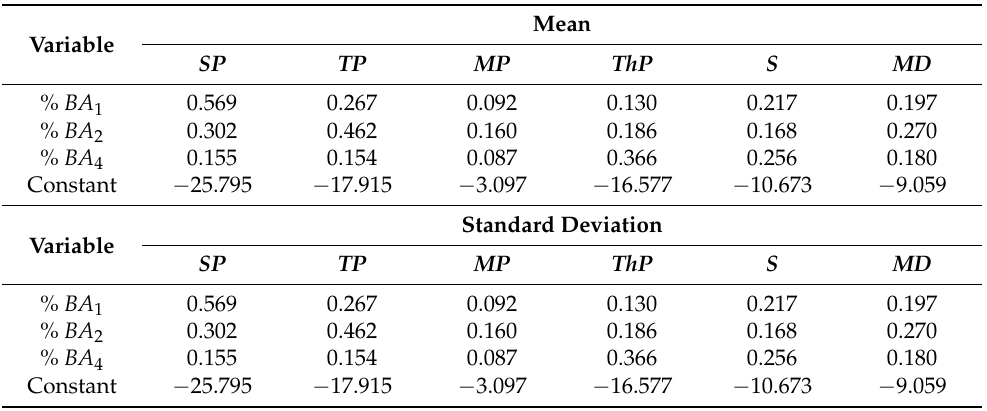
Table 6. Results of the discriminant variables for each typology: the mean and standard variation by group value ( SP : Seedling Poles; TP : Thin Poles; MP : Medium Poles; Th : Thick Poles; S : Stratified; MD : Multi-diameter).